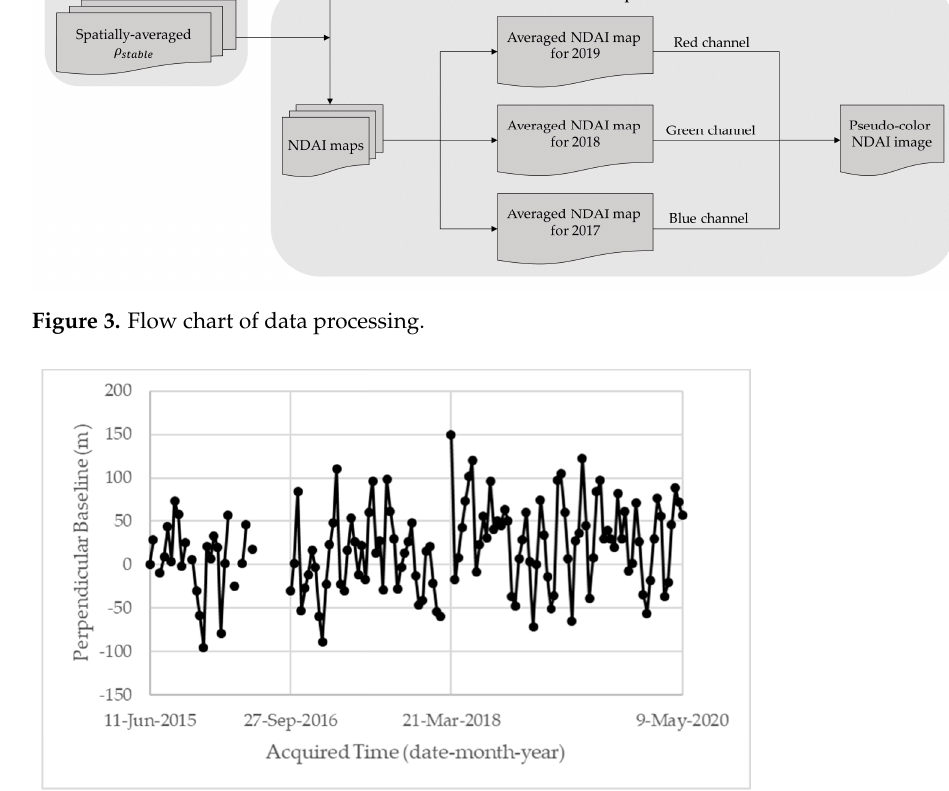
( c ) Figure 5. Selection process of stable points. ( a ) Time-averaged coherence image. ( b ) Standard deviation image. ( c ) Stable points in blue color. The red polygon is the mining area, the region of interest.